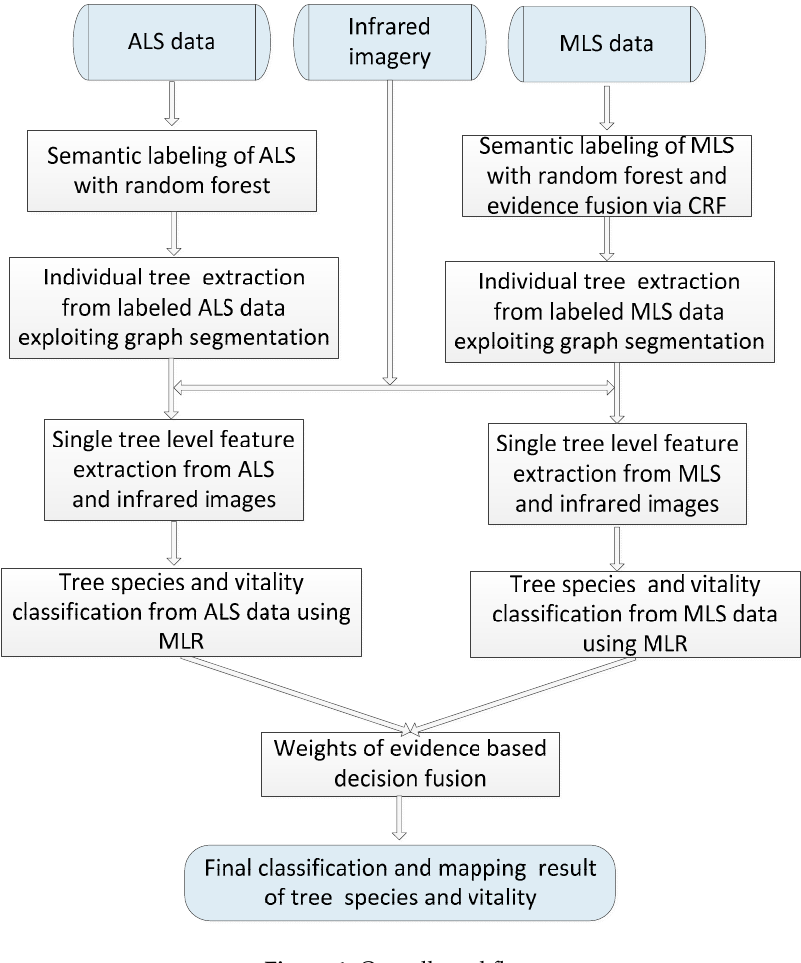
Figure 1. Overall workflow.